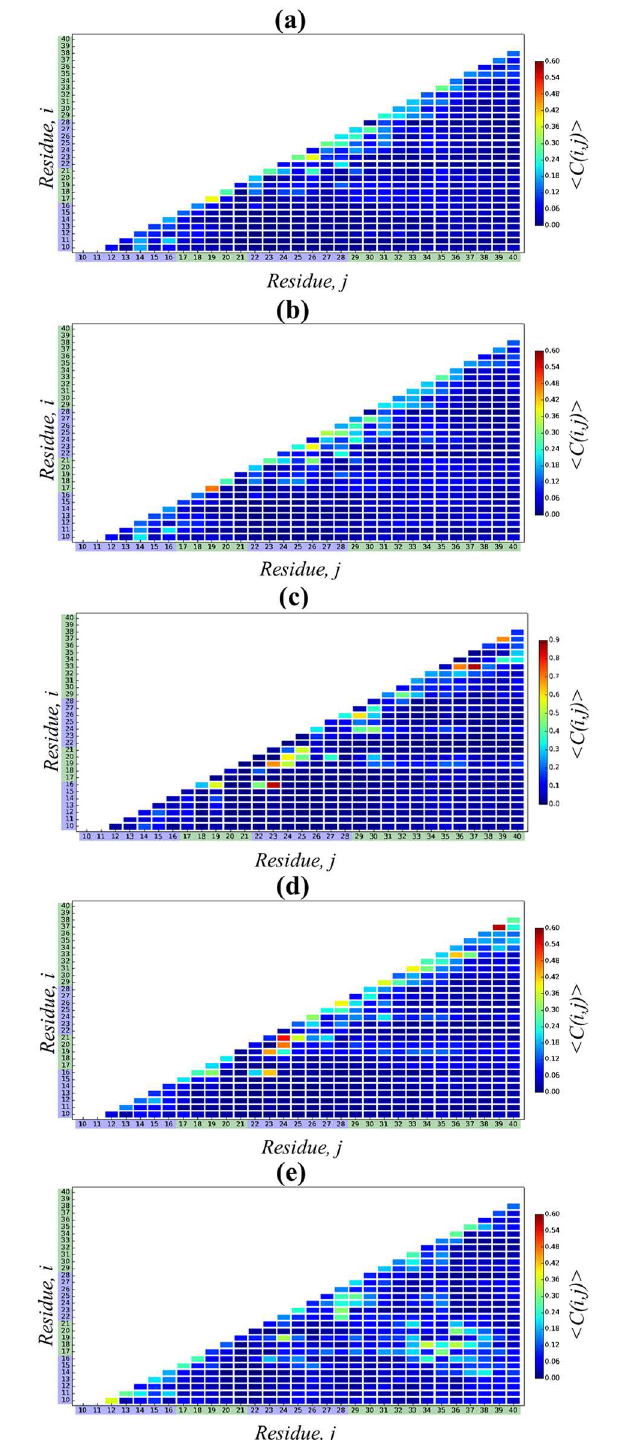
Fig 5. A β 10-40tertiary interactions in different force fields. Intrapeptide contact maps, h C ( i , j ) i , present the probabilities of forming contacts betweenresidues i and j in A β 10-40peptidefor five force fields: (a) C36,